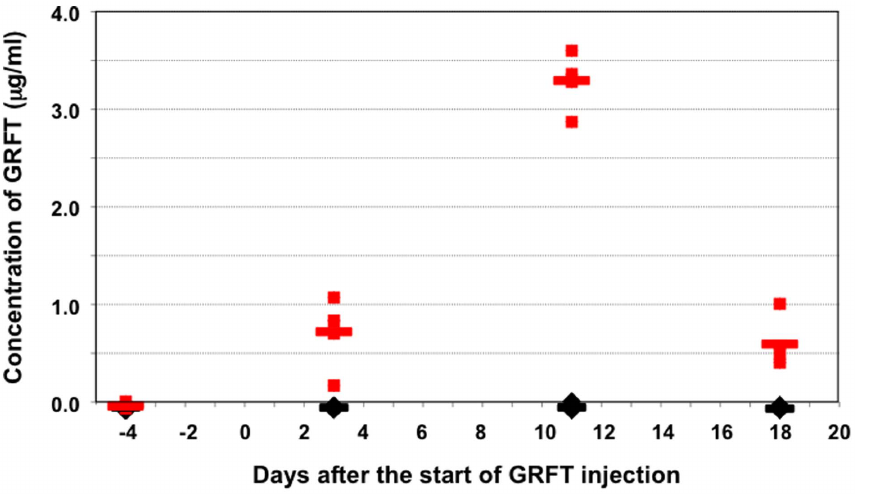
Figure 6. Plasma levels of GRFT following subcutaneous injection into mice. GRFT (20 mg/kg day, Q24) was injected into Alb-uPA/SCID transgenic mice for ten consecutive days. Blood was drawn at the indicated days and plasma was measured for GRFT content by ELISA capture assay as described in the Materials and Methods section. Individual animals are shown as red squares (GRFT-treated, n=5) or black diamonds (control animals, n=5). Horizontal bold lines represent the mean values for each group.